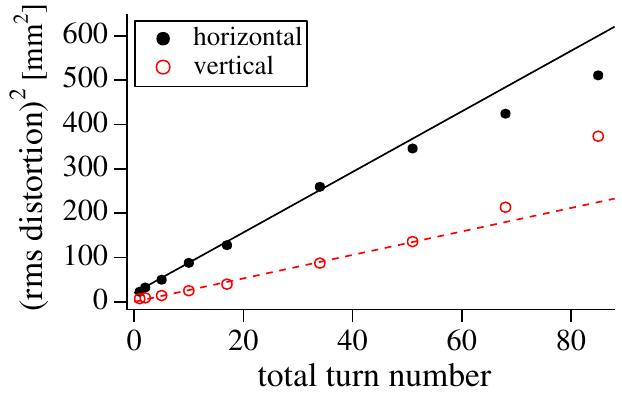
FIG. 13. (Color) Square of rms distortion for different accelera- tion rate. Filled and empty circles are simulation results and the solid and dashed lines are the random walk